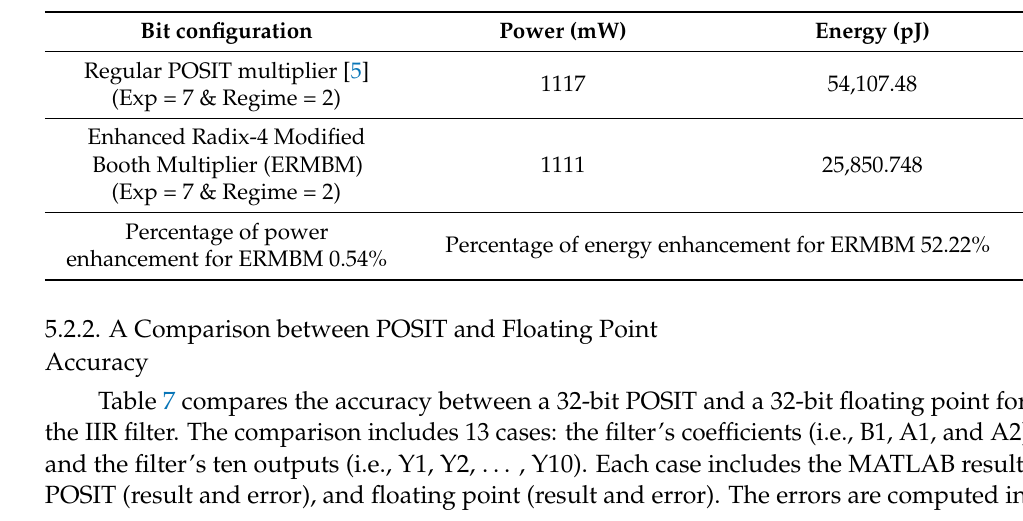
Table 6. Comparison of the regular multiplier with ERMBM for power and